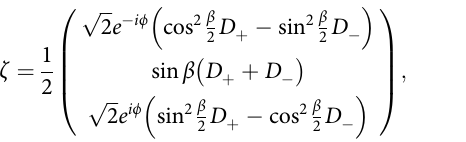
represents the interpolation between the FM and P phases for F varying from 1 to 0, respectively. The azimuthal angle around the vortex line is represented by ϕ , and β is the polar ^ F i ¼ F ð sin β ^ ρ þ cos β ^ z Þ , and the unit angle. The spin vector is h